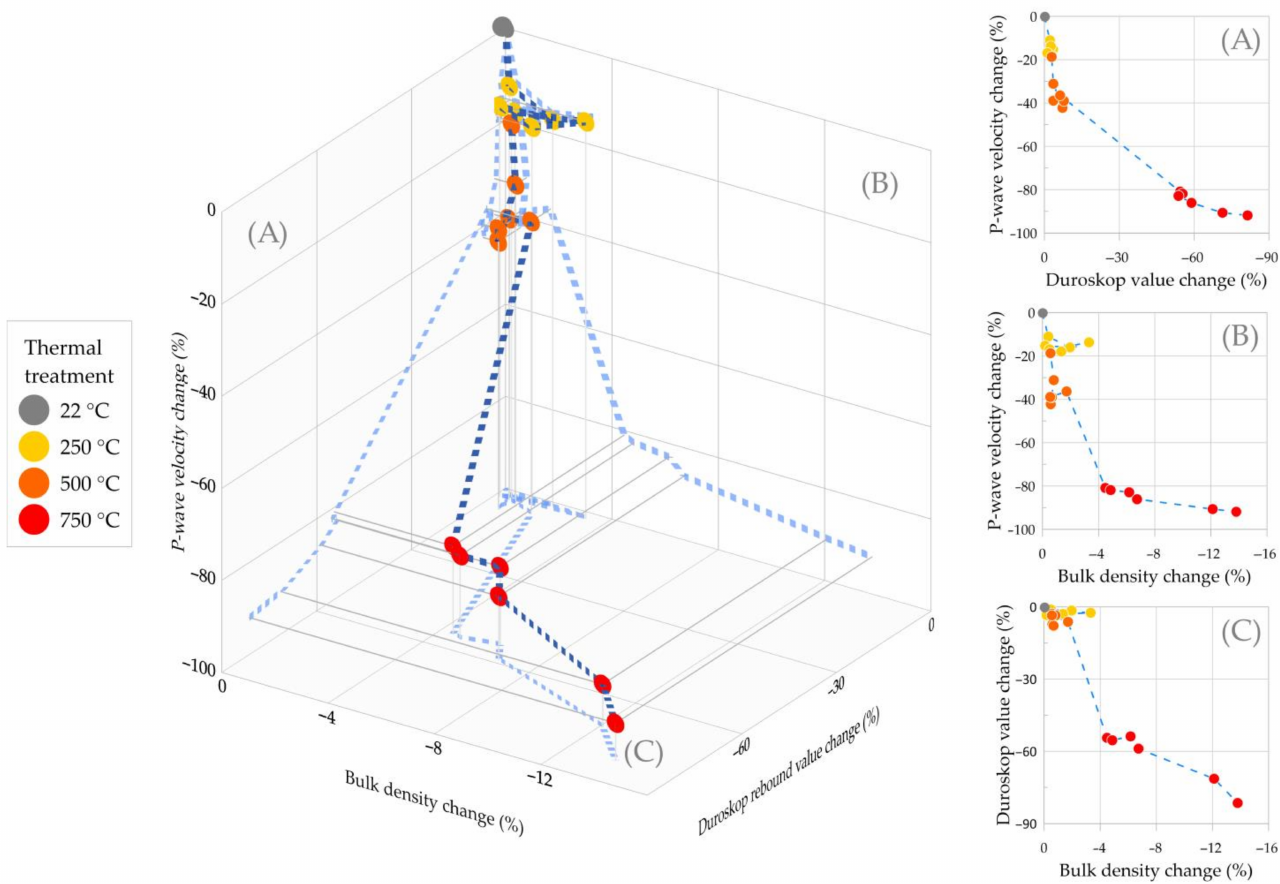
Figure 16. 3D scatter plot of bulk density-, P-wave velocity- and Duroskop value percental changes ( left ). 2D class scatter of P-wave velocity- and Duroskop value percental changes ( A ). 2D class scatter of P-wave velocity- and bulk density value percental changes ( B ). 2D class scatter of Duroskop value and bulk density percental changes ( C